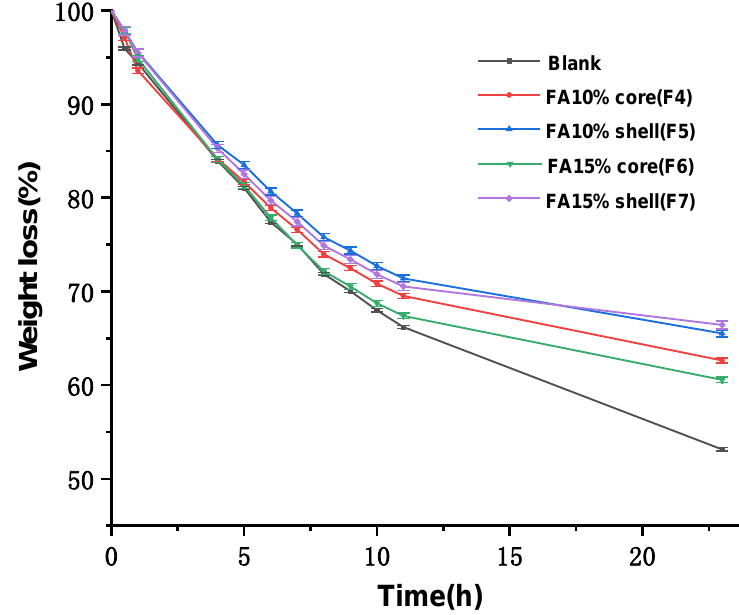
Figure 13. Weight loss analysis of apple slices after contact packaging.